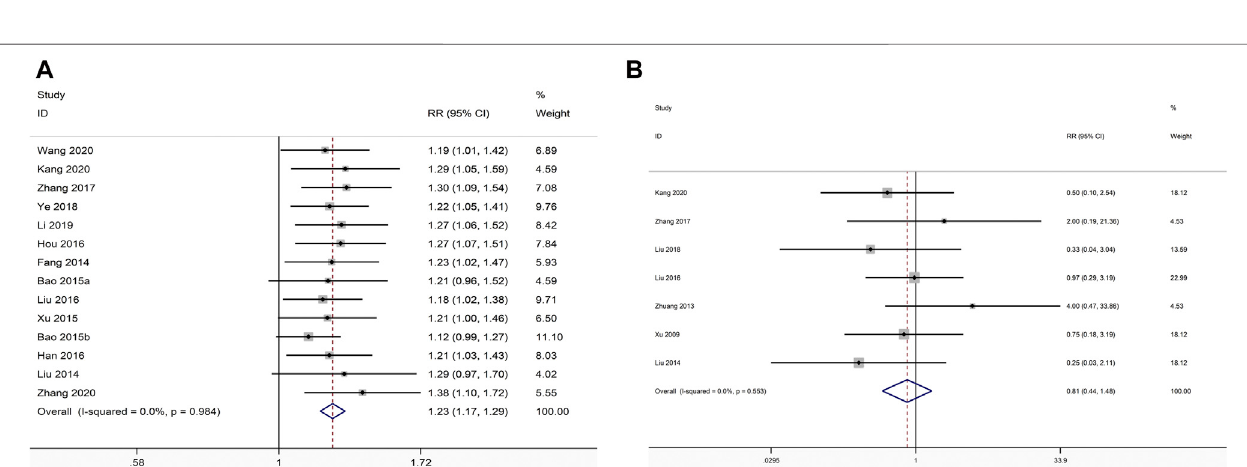
Frontiers in Pharmacology |